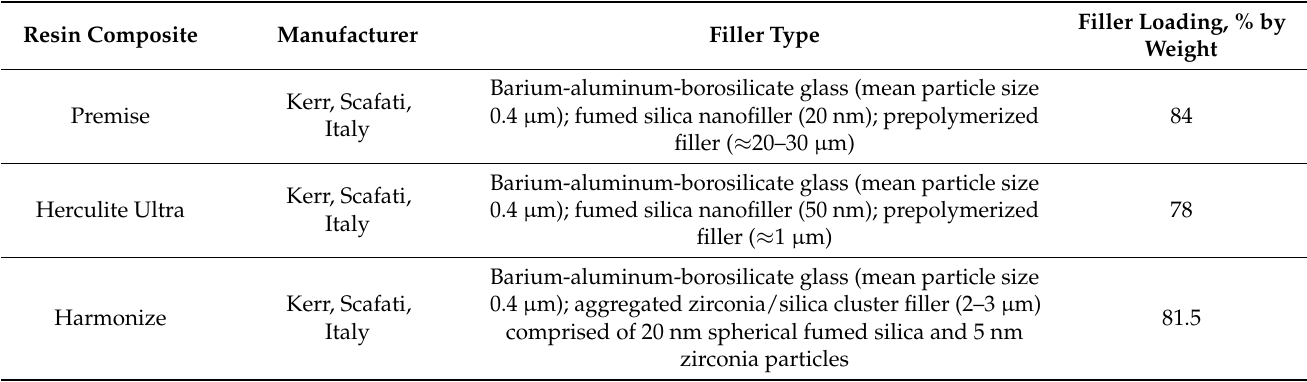
Table 1. Composition of the resin composite materials used in this